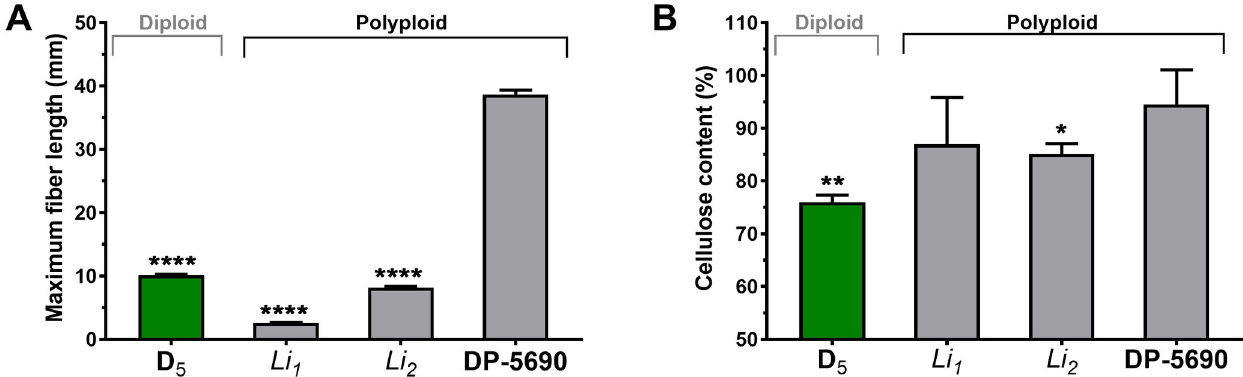
Fig 3. Fiber phenotype variations between short fiber G . hirsutum mutants and their near isogenic line DP-5690 (2 nd set). A. Maximum fiber length. Fiber length of G . hirsutum short fiber Li and Li mutants were manually measured and compared with those of their NIL, G . hirsutum DP-5690 and wild 1 2 diploid G . raimondii D 5 -31 (D 5 ). B. Cellulose content. The error bars represent standard deviation. � p value < 0.05; �� p value < 0.01; ���� p value < 0.0001.